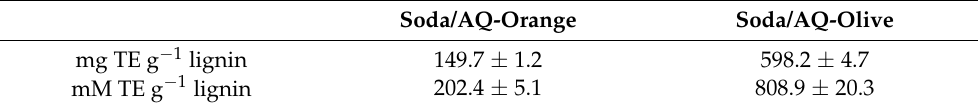
Table 4. Trolox equivalent antioxidant capacity of soda/AQ lignins.